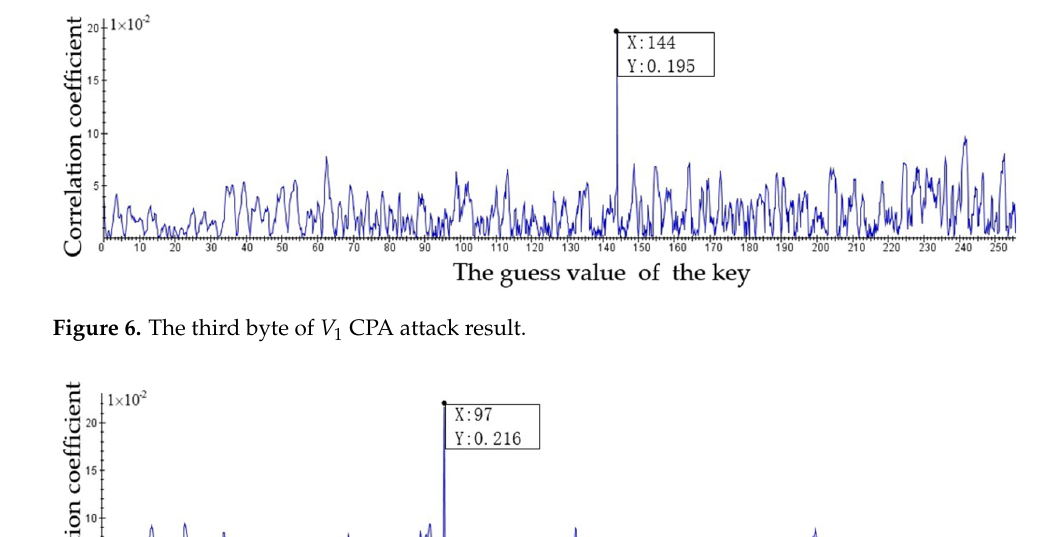
Figure 5. The second byte of V 1 CPA attack result.